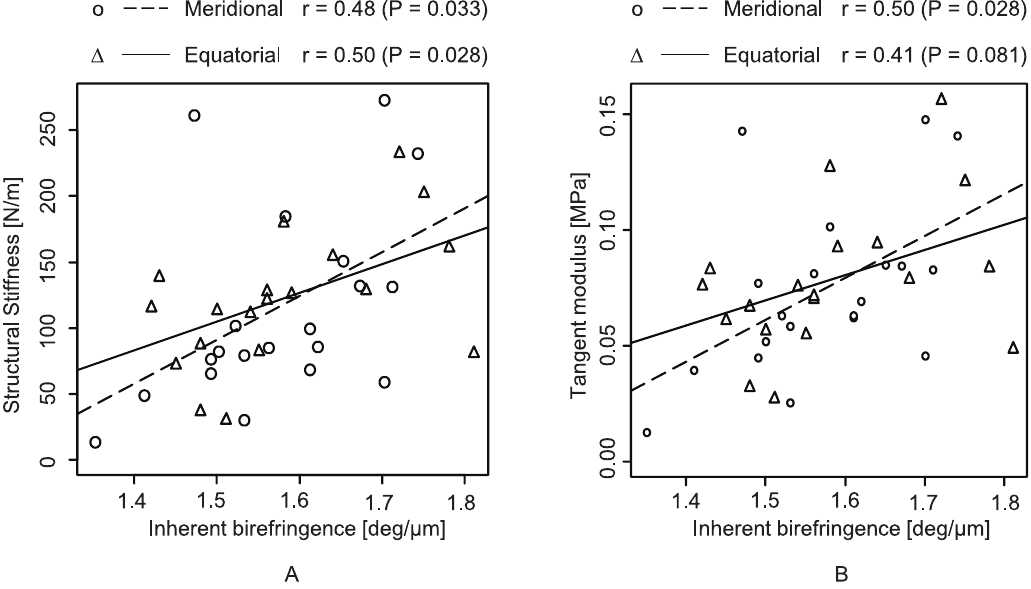
Figure 6. Plots of elastic parameters of structural stiffness (A) and tangent modulus (B) against inherent birefringence. doi:10.1371/journal.pone.0058716.g006 PLOS ONE |